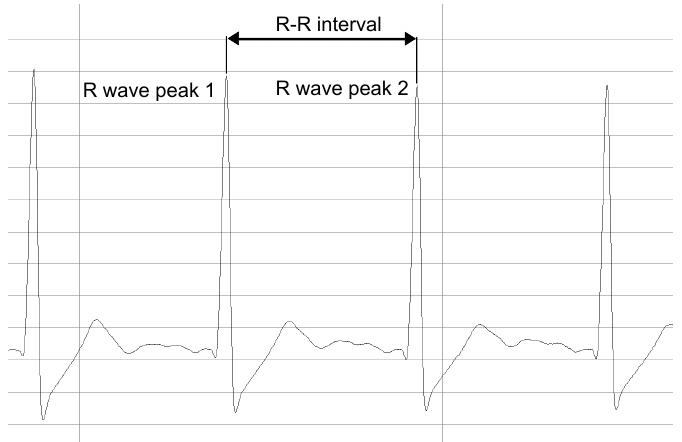
Figure 1. RR Peak